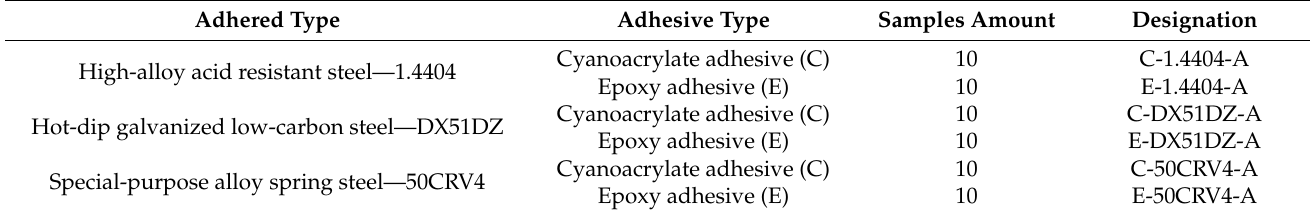
Table 5. Designations of adhesives joints—variant A of surface